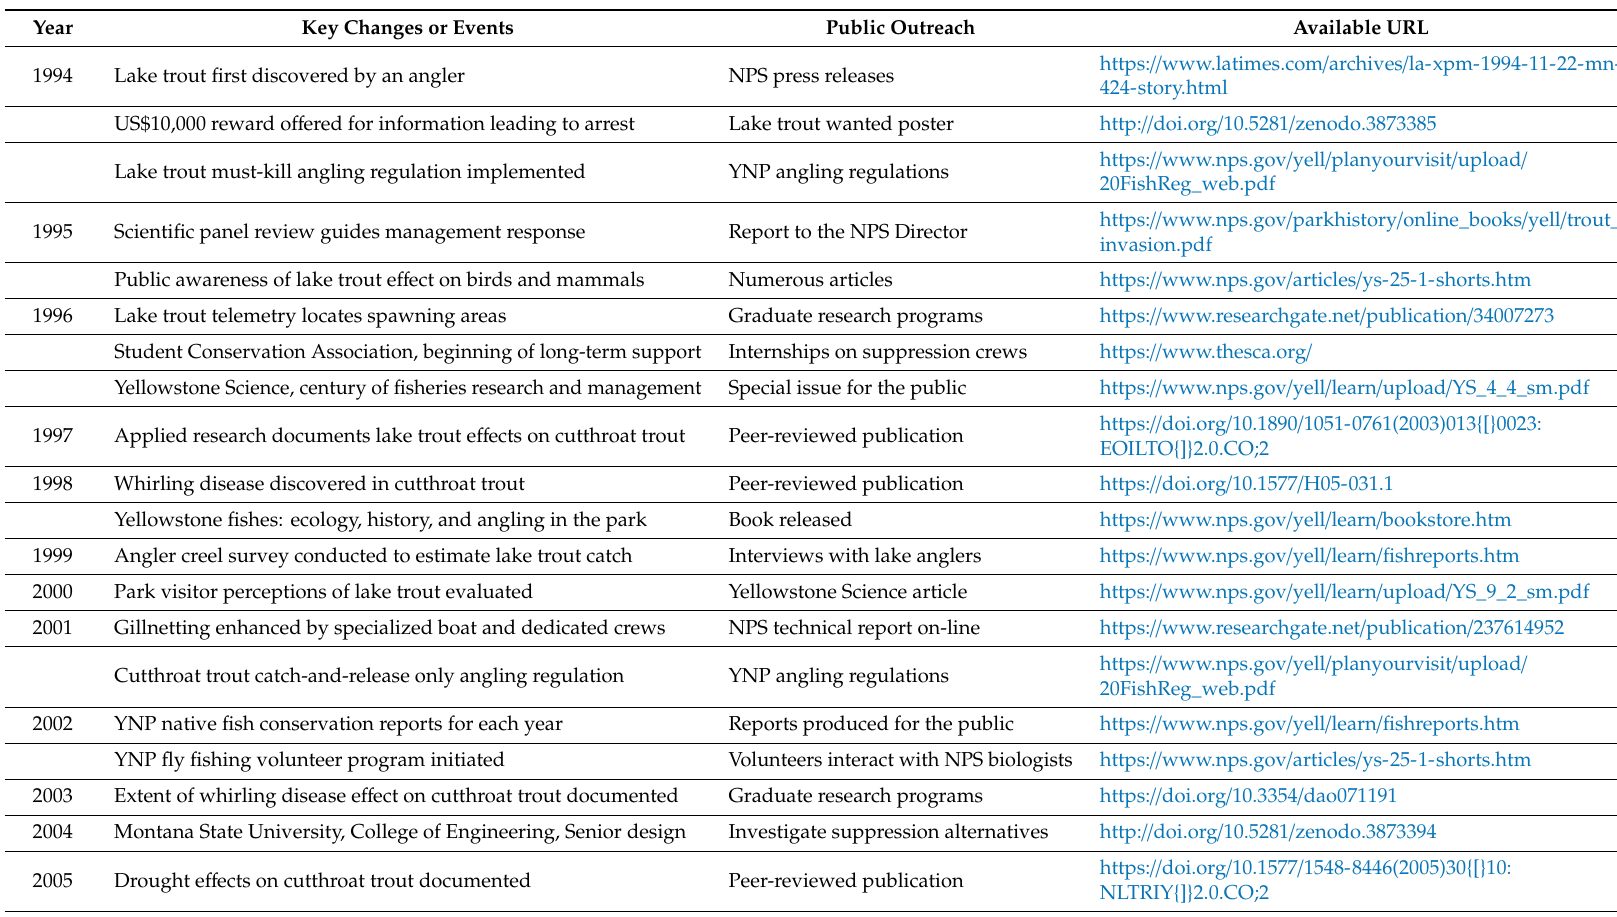
Table A2. Public support played an important role in the Yellowstone Lake ecosystem restoration program. Outreach occurred via multiple sources using a wide range of media types. Information exchange with the public and program involvement by students, volunteers, interns, agency partners, and conservation organization sta ff were critical for highlighting the consequences of lake trout and helping to secure funding. This timeline identifies key events or changes that occurred, the public outreach that resulted, and links to available literature or other information